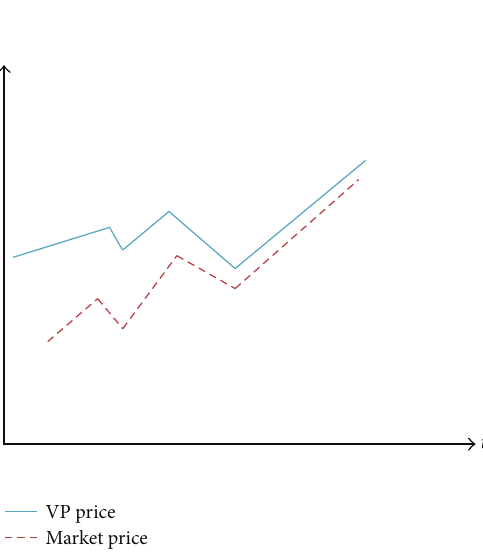
Figure 3: Variable-premium price